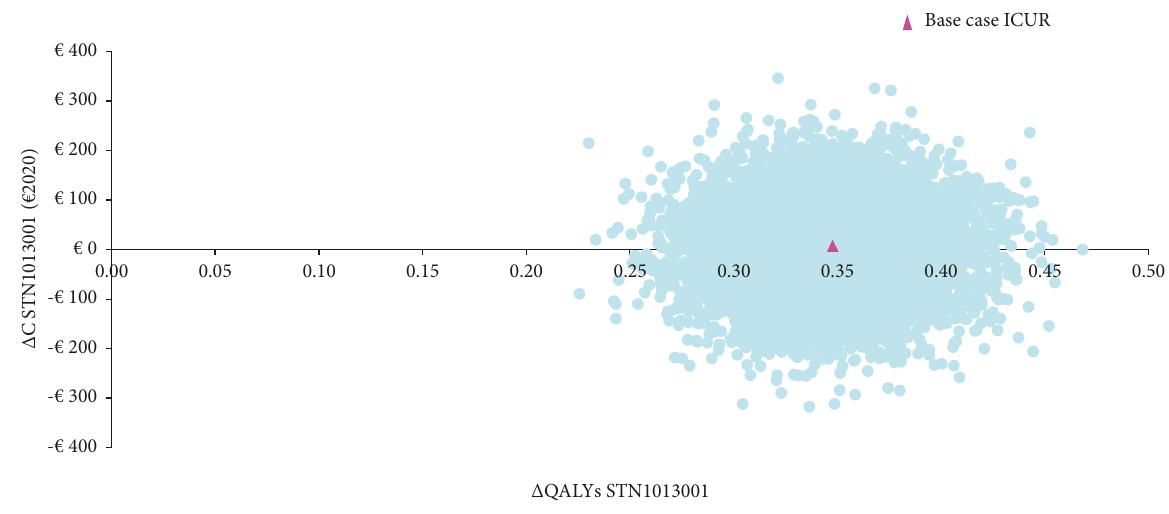
Figure 4: Probabilistic sensitivity analysis-I-cost-effectiveness plane (10,000 out of 10,000 Monte Carlo iterations reported) ( 21.26 (NE sector of the cost-effectiveness plane). Number of Monte Carlo iterations (%) for each sector of the